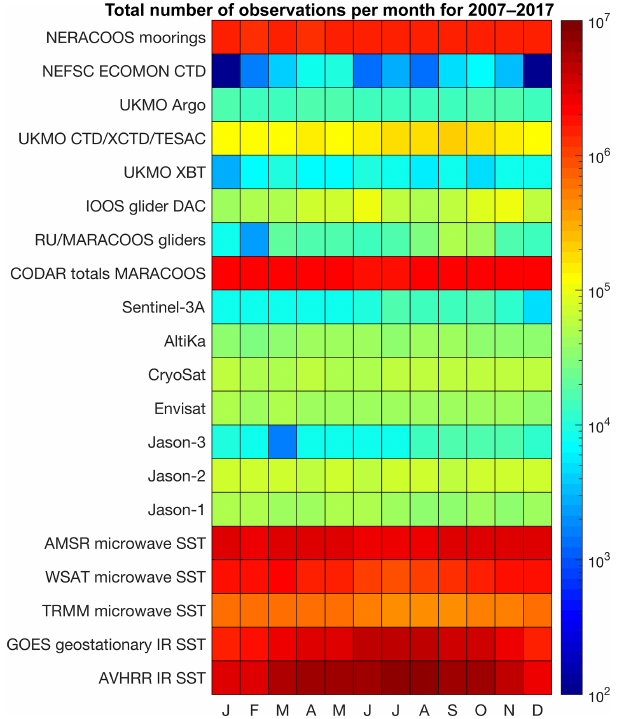
Figure 5. Total observations by month for the individual data sources used in skill assessment over the 2007–2017 period. The log color scale indicates quantity of observations. UKMO: UK Met Office. XCTD: expandable conductivity, temperature, and